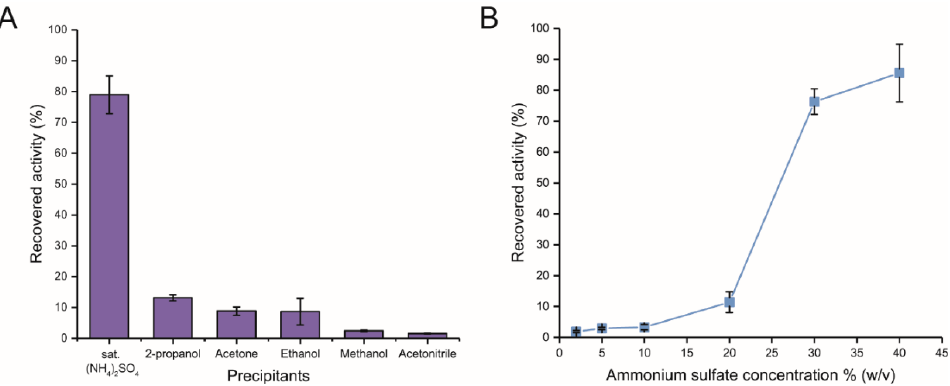
Figure 1. ( A ) Precipitation of R483A-LrInu with different precipitating agents. ( B ) The effect of ammonium sulfate concentration on the recovered activity of precipitated R483A-LrInu. The data represent the mean of three assays and the error bars represent the standard deviation of three experiments.